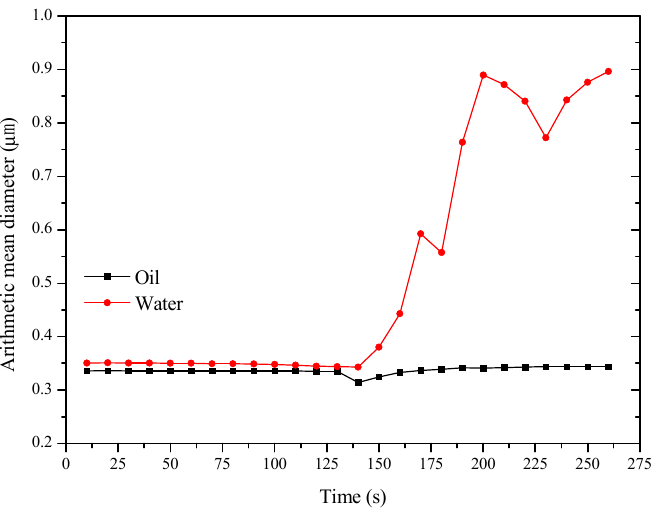
Figure 7. Comparison of changes in particle arithmetic mean diameter when heating water and corn oil.